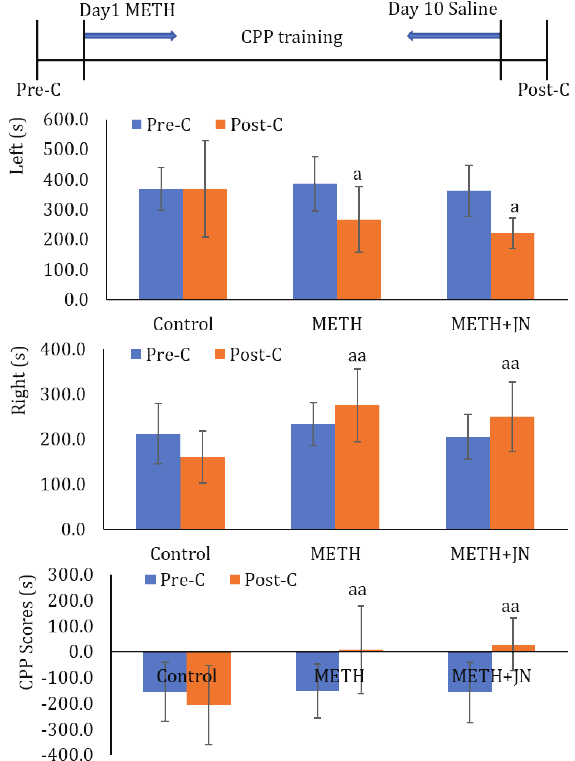
Figure 2: Effects of single dose Jinniu Capsule on METH-induced